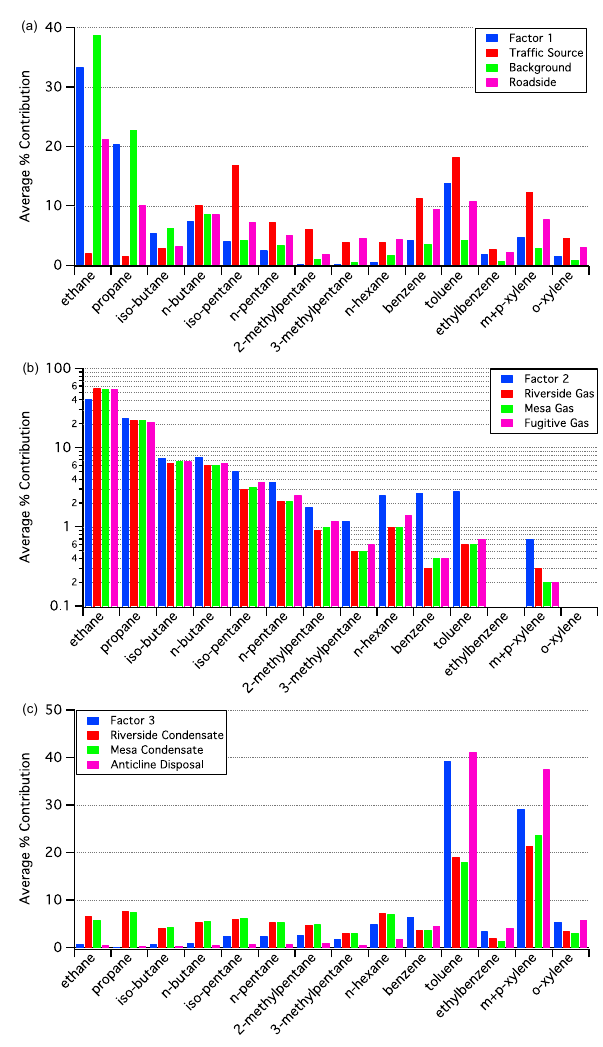
Figure 6. (a) Comparison of factor 1 with emission source profiles as percentage contribution by mass for selected NMHC. (b) Com- parison of factor 2 with emission source profiles as percentage con- tribution by mass for selected NMHC. (c) Comparison of factor 3 with emission source profiles as percentage contribution by mass for selected